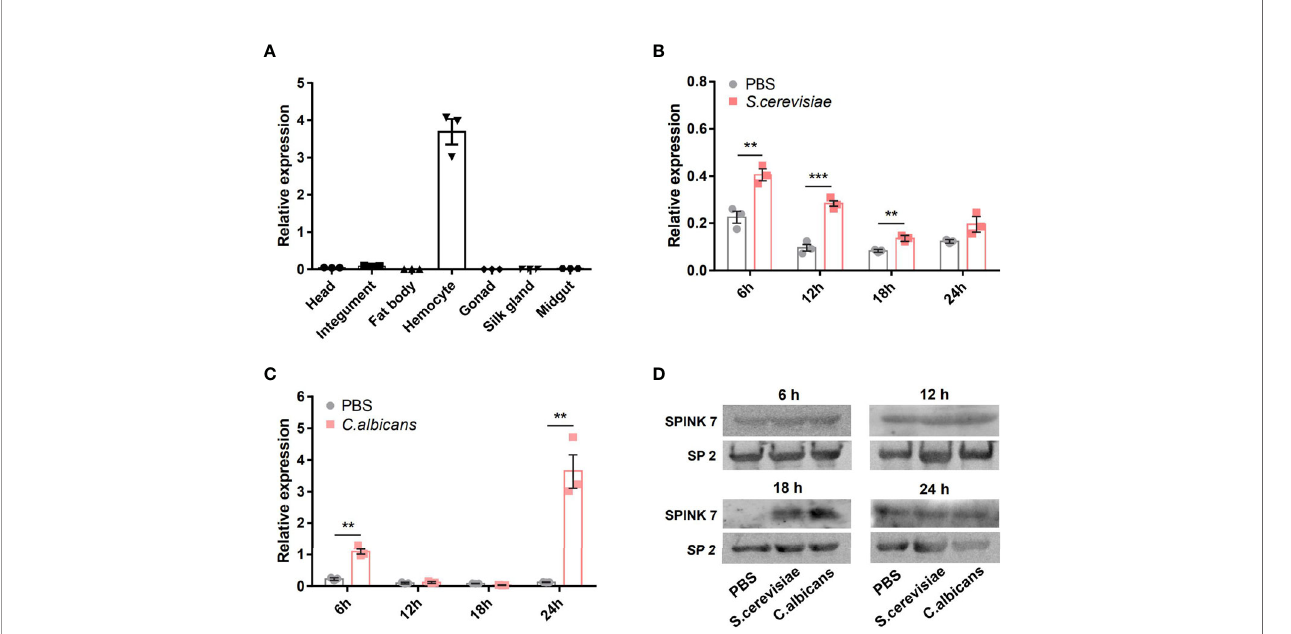
FIGURE 3 | SPINK7 expression pro fi les. The expression patterns of SPINK7 in seven tissues (A) , including head, integument, fat body, hemocytes, gonad, silk gland, and midgut. SPINK7 mRNA expression levels in larval hemocytes at 6, 12, 18, and 24 h after infection with (B) S. cerevisiae and (C) C. albicans . Vertical bars represent the mean ± standard error of the mean (n = 3). Student ’ s t-test: ***P < 0.001 and **P < 0.01. SPINK7 protein in larval serum was detected by Western blot (D) at 6, 12, 18, and 24 h after infection with S. cerevisiae and C. albicans . The storage protein 2 was used as a loading